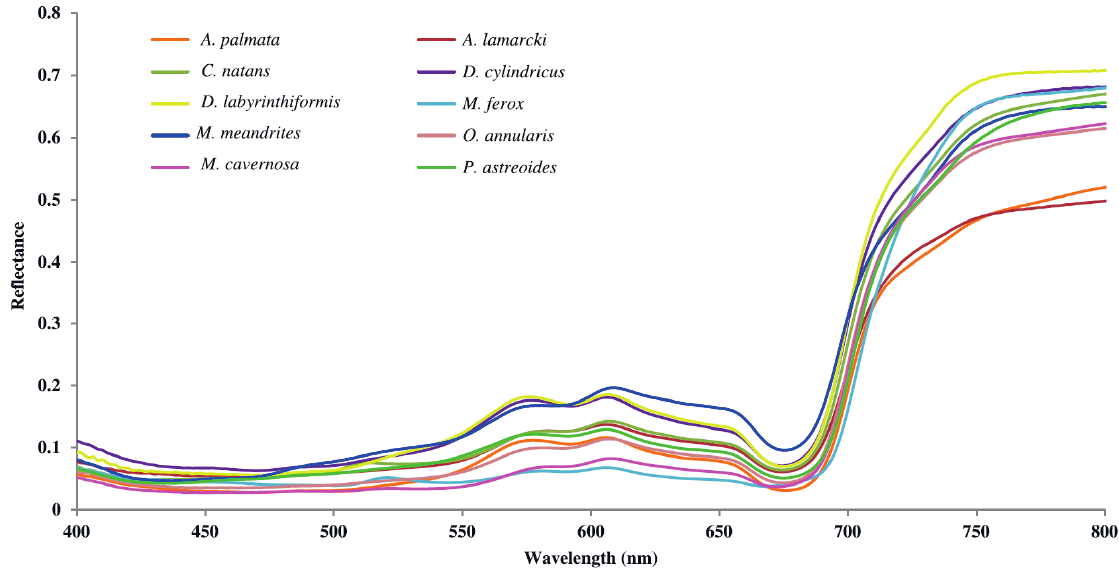
Figure 4. Representative average spectra for ten coral species; examples shown here are subset of the 25 total Cnidarian species sampled (5556 samples; 1389 reflectance